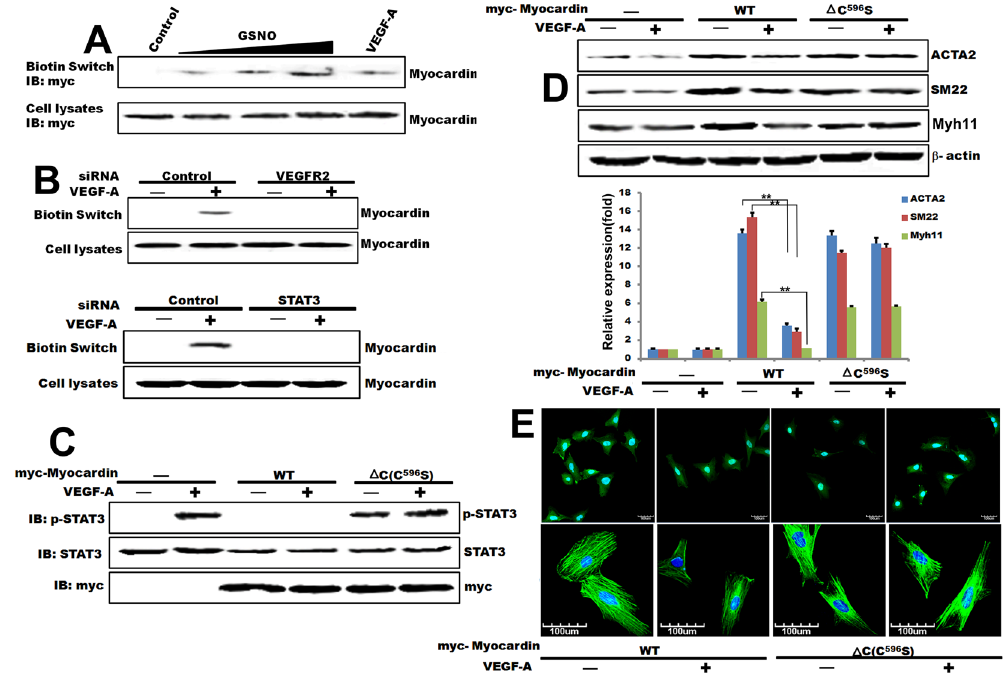
Figure 3. Myocardin nitrosylated at Cys596 is required for STAT3 activation in VSMC phenotypic switch by VEGF-A. ( A ) Biotin switch analysis of T/G HA-VSMC cells transfected with Myc-tagged Myocardin and followed by treatment with 200 μ M GSNO for 10 min or 100 ng/mL VEGF-A for 48 hours ( B ) Biotin switch analysis of T/G HA-VSMC cells transfected with a 100 pmol of VEGFR2 or STAT3 siRNA mixture and 2 μ g of Myc-tagged Myocardin and subsequently treated with 100 ng/mL VEGF-A for 48 hours. ( C ) Western blot analysis of T/G HA-VSMC cells transfected with Myocardin-WT or Myocardin- Δ C and activated with 100 ng/ mL VEGF-A for 48 hours. The phosphorylated STAT3 and total STAT3 protein was determined by Western blot analysis in the cell lysates. ( D ) Western blot analysis of ACTA2, SM22 and Myh11 protein level in T/G HA-VSMC cells transfected with Myocardin-WT or Myocardin- Δ C then treated with 100 ng/mL VEGF-A for 48 hours and quantified the western blot data by Quantity One software. β -actin is a loading control. ** p < 0.01. n = 3. ( E ) Immunofluorescence technique of Myh11 and ACTA2 protein level in T/G HA-VSMC cells transfected with Myocardin-WT or Myocardin- Δ C then treated with 100 ng/mL VEGF-A for 48